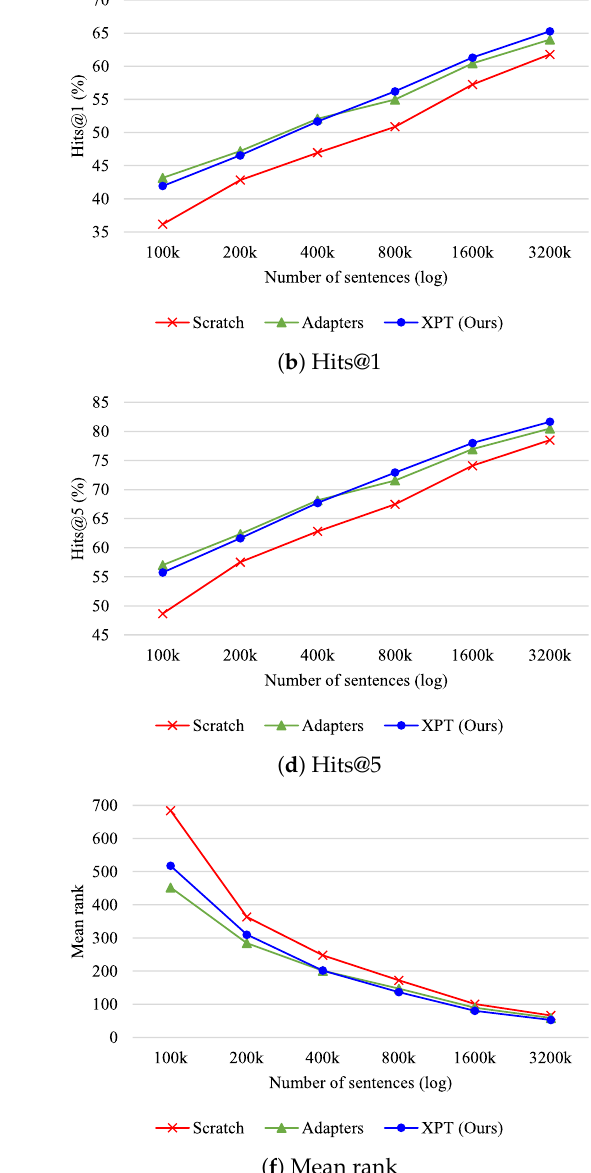
Figure 3. Intrinsic evaluation results as a function of the number of training